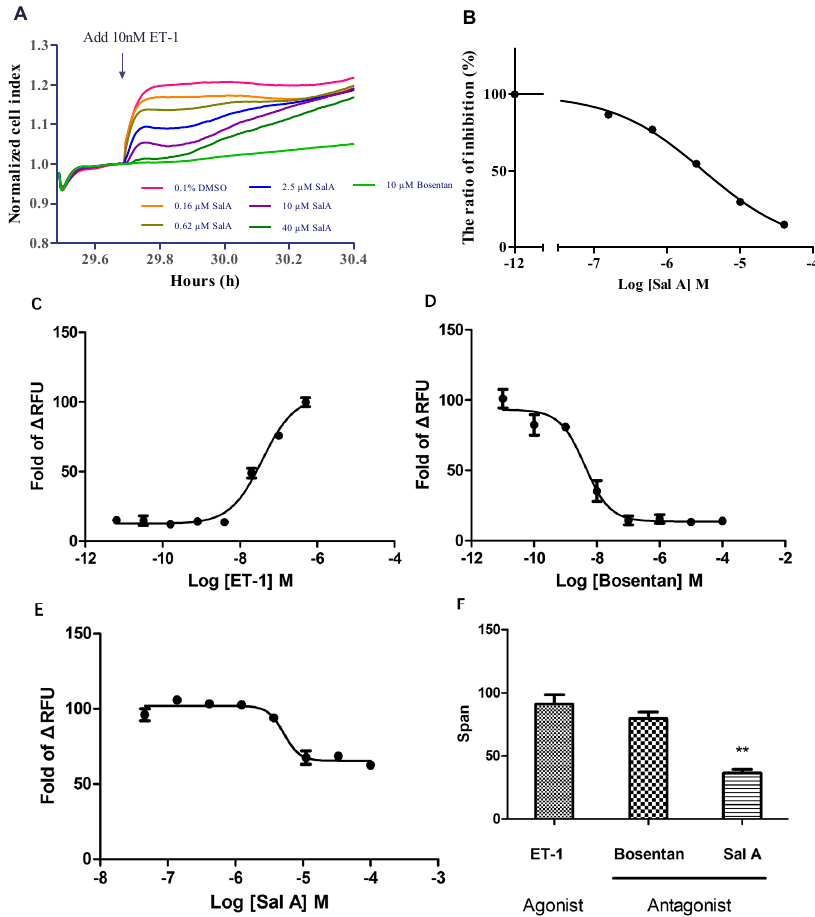
Figure 4. Effect of Sal A on ( A , B ) ET-1 stimulated cell index and ( C – F ) calcium influx in HeLa cells. ( A ) Time-dependent cell index (CI) curves are shown, dose concentration of Sal A and 10 µM Bosentan (positive control) were added at 29.4 h. After 15 min, 10 nM ET-1 was added. Black arrow: compound addition; ( B ) Concentration–response curves of Sal A calculated by (Max CI − Min CI ) during 29.7 to 30.4 h. The IC 50 value of Sal A was 3.14 µM; ( C ) Concentration–response curve of ET-1 agonist in HeLa cells. The EC 50 value was 39 nM; ( D ) Concentration–response curves of Bosentan in HeLa cells. The IC 50 value was 4.3 nM; ( E ) Concentration–response curves of Sal A in HeLa cells. The IC 50 value was 5.19 µM; ( F ) The comparison with response-span of three compounds. Data ( C – E ) were expressed as the fold change of max RFU and min RFU. Data are expressed as means ± SD of three independent experiments. Statistical analysis was conducted by using one-way ANOVA with Tukey test. ** p < 0.05.